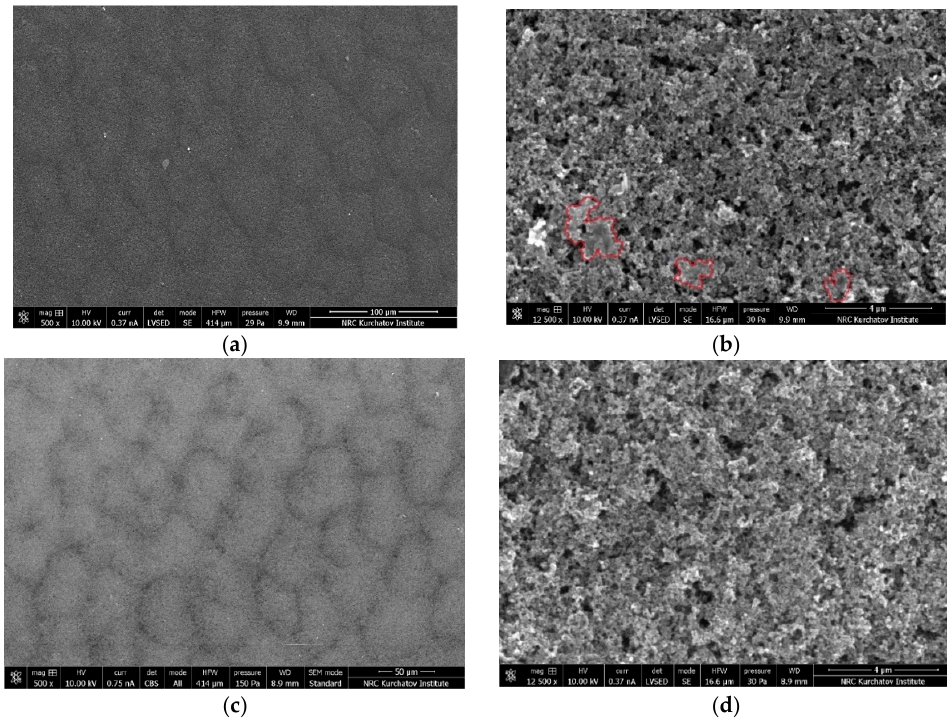
Figure 3. SEM images of Pt 40 /C-coated electrodes before ( a , b ) and after ( c , d ) RDE measurements.